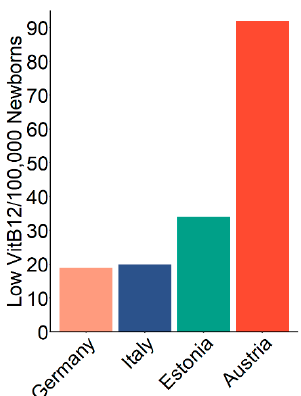
Figure 6. Estimated/reported detection of low vitamin B12 (VitB12) prevalence from different newborn-screening facilities. Germany refers to reference [6], Italy to reference [3] and Estonia to reference [10]. Beige bars show values for the estimated detection of low VitB12 in Germany, dark blue bars for Italy, green bars for Estonia and red bars for Austria.